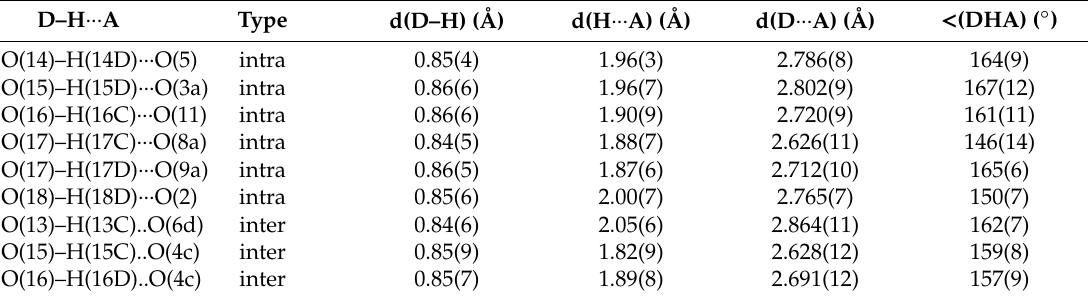
Table 3. Hydrogen bonding contacts A–H ··· B for Complex 1.